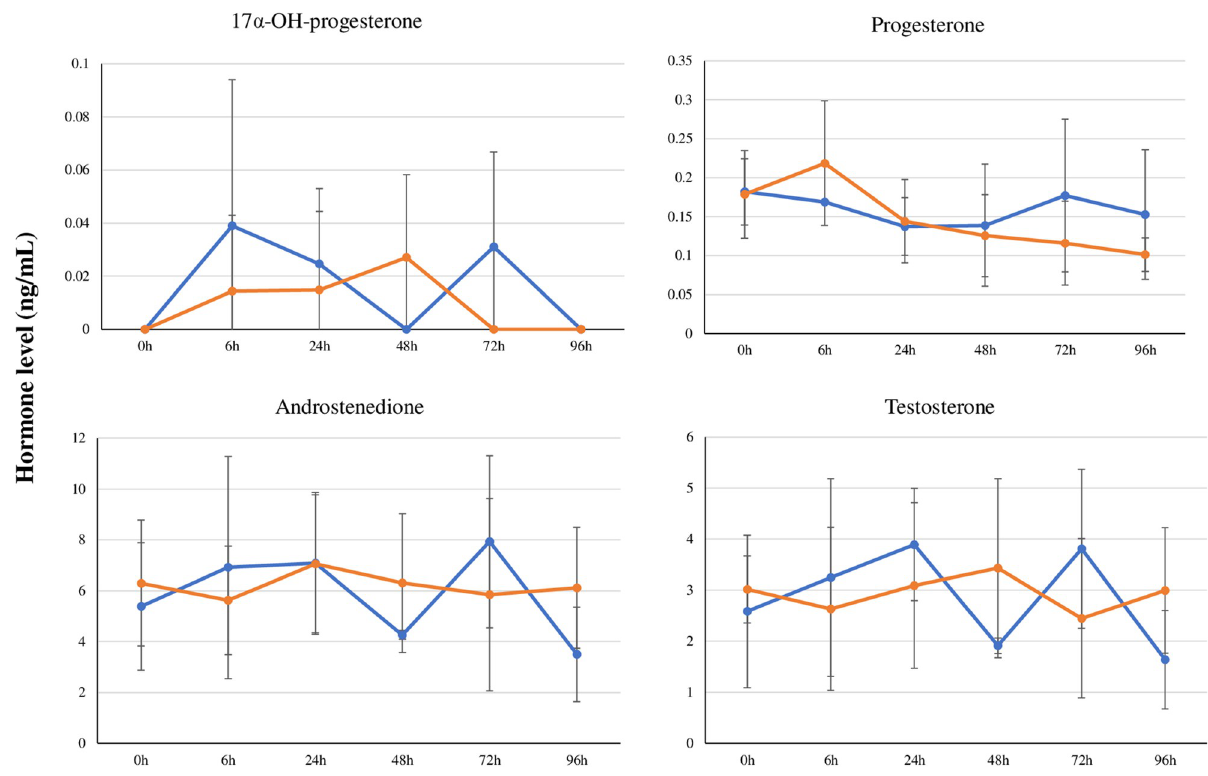
Fig 3. Time course of the serum sex hormone levels (mean ± SD) in time courses of the control (blue) and PCB treatment (orange) groups.